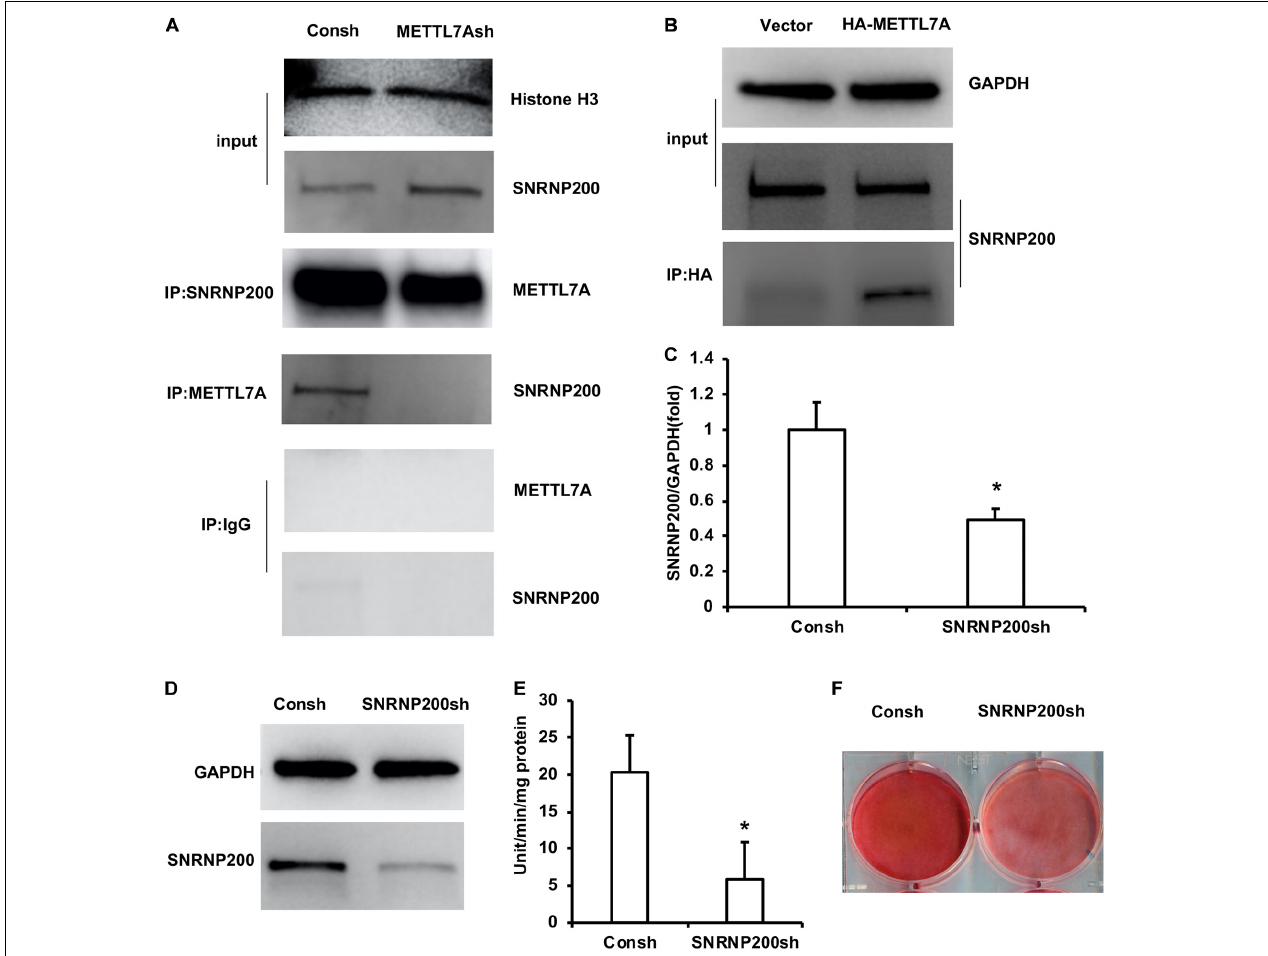
FIGURE 5 | SNRNP200, identified as a co-binding protein of METTL7A, promoted odontogenic differentiation of DPSCs. (A) The association of SNRNP200 and METTL7A in METTL7A-knockdown DPSCs detected by the Co-IP assay. (B) The association of SNRNP200 and METTL7A in METTL7A-overexpressed DPSCs detected by the Co-IP assay. (C,D) The expression of SNRNP200 was detected by real-time RT-PCR and western blot. (E) ALP activity after 5 days of mineralized induction. (F) ARS after 2 weeks of induction. GAPDH and histone H3 were used as internal control. Student’s t -test was performed to determine statistical significance. All error bars represent the standard deviation ( n = 3). * p ≤